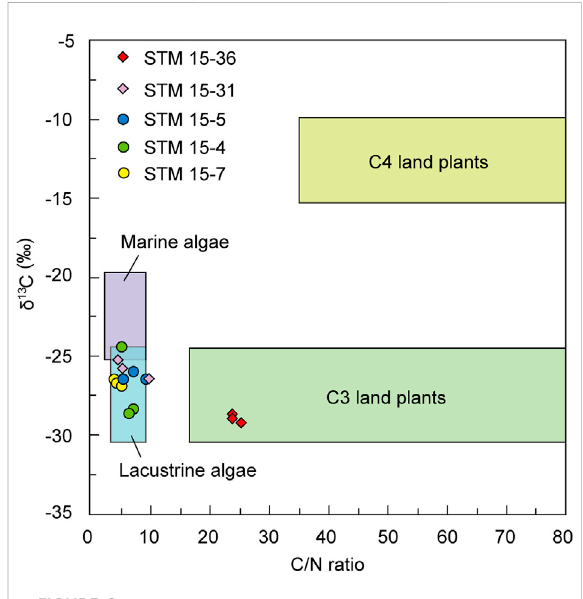
FIGURE 6 δ 13 C fi ers for major sources of plant org and C/N value identi organic matter to subaqueous sediments (Meyers, 1994). Data from Toudaoyingzi are shown as rhombi, and data from Dapingfang are shown as